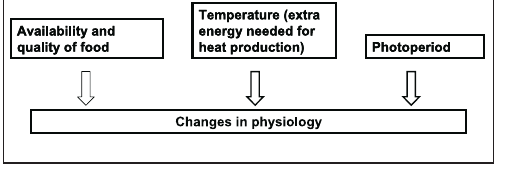
Fig. 1. Seasonal changes in photoperiod, temperature, and availability of food are the main environ- mental cues that through hormones induce the adaptive changes that enable the reindeer to sur- vive the winter.